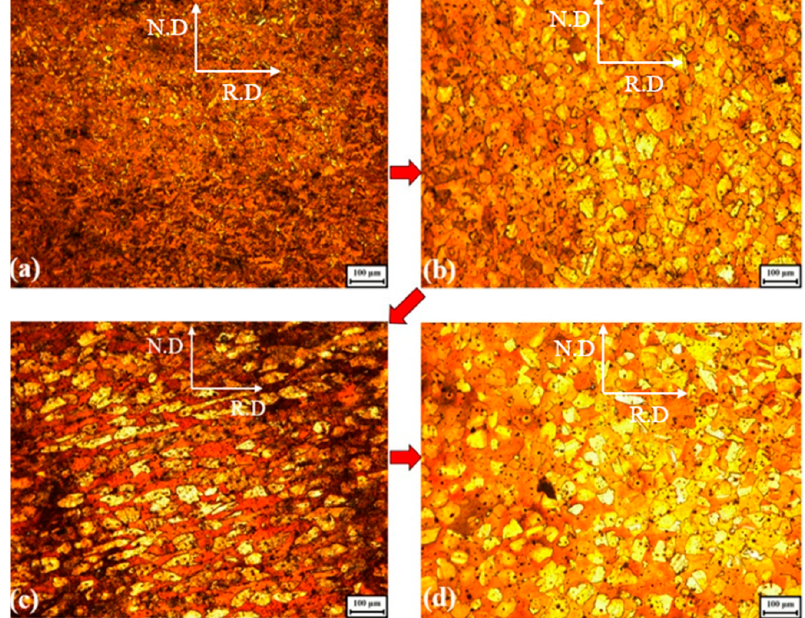
Figure 4. Microstructural evolution of brass at four different stages: ( a ) raw material, ( b ) sample after annealing at 600 °C for 12 hours, ( c ) sample after re-cold rolling, and ( d ) sample after re-annealing at 600 °C for 12 hours. (N.D is the normal direction and R.D is the rolling direction).